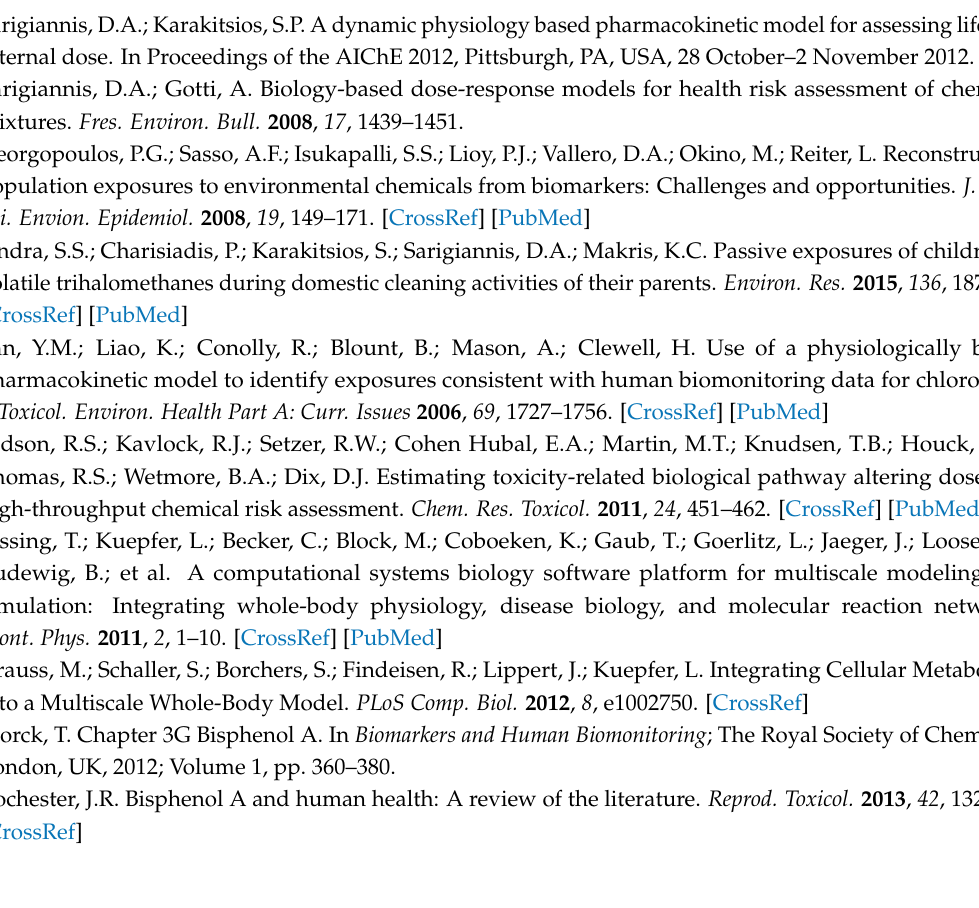
Table S1: Regression coefficients for lifetime scaling (from conception to adulthood), Table S2: Gestation parameters (from conception to birth), Table S3: Partition coefficients (organ/blood), Table S4: Model parameters for MCMC